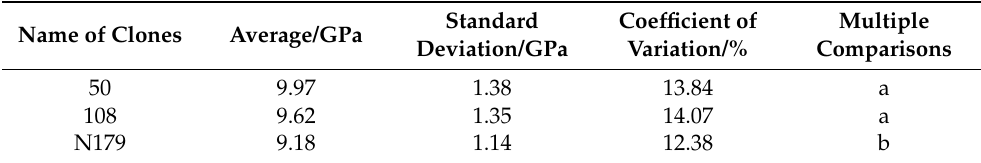
Table 4. Statistical results of MOE in three poplar clones.